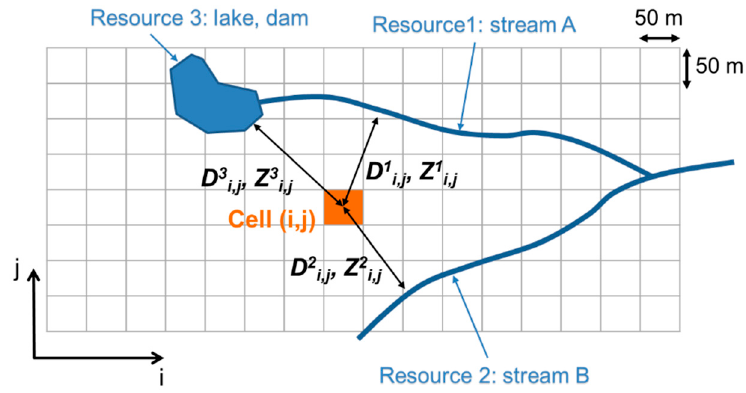
Figure 2. Cells gridding of the study area (example for a case with n = 3 available water resources: two streams and one lake). D n i , j and H n i , j are, respectively, minimum distance and elevation difference between the cell ( i,j ) and resource n.